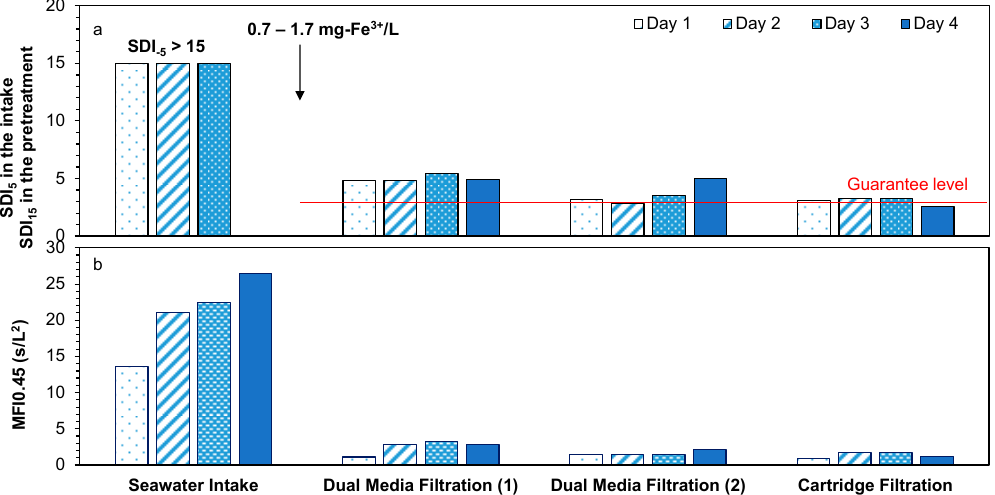
Figure 2. ( a ) Silt density index of 5 min (seawater intake) and 15 min (other samples) and ( b ) modified fouling index of 0.45 µm for the SWRO pretreatment processes of the SWRO desalination plant. Chlorination was applied on day 4 .